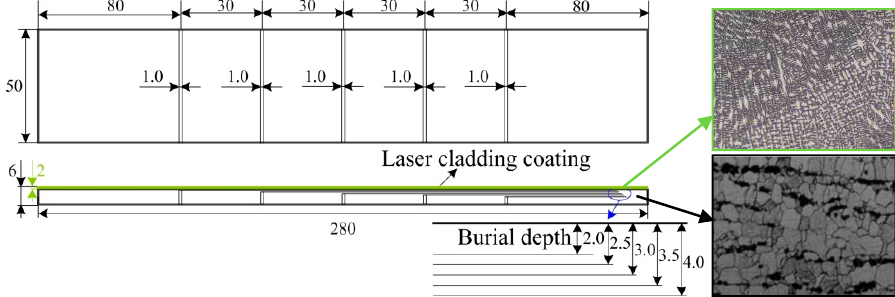
Figure 1. Sketch map of laser cladding Fe314 alloy coating with burial cracks. Table 1. Vacuum heat treatment technology.